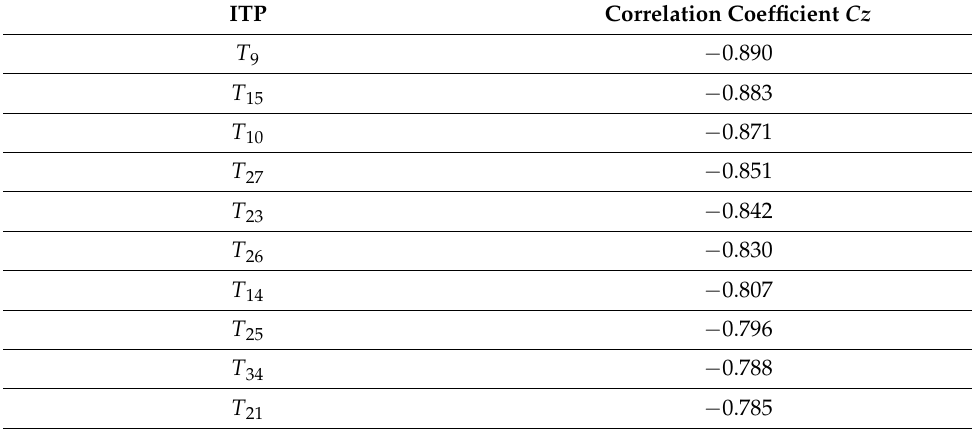
Table 5. The five ITPs with the strongest negative correlations with the spindle displacement.